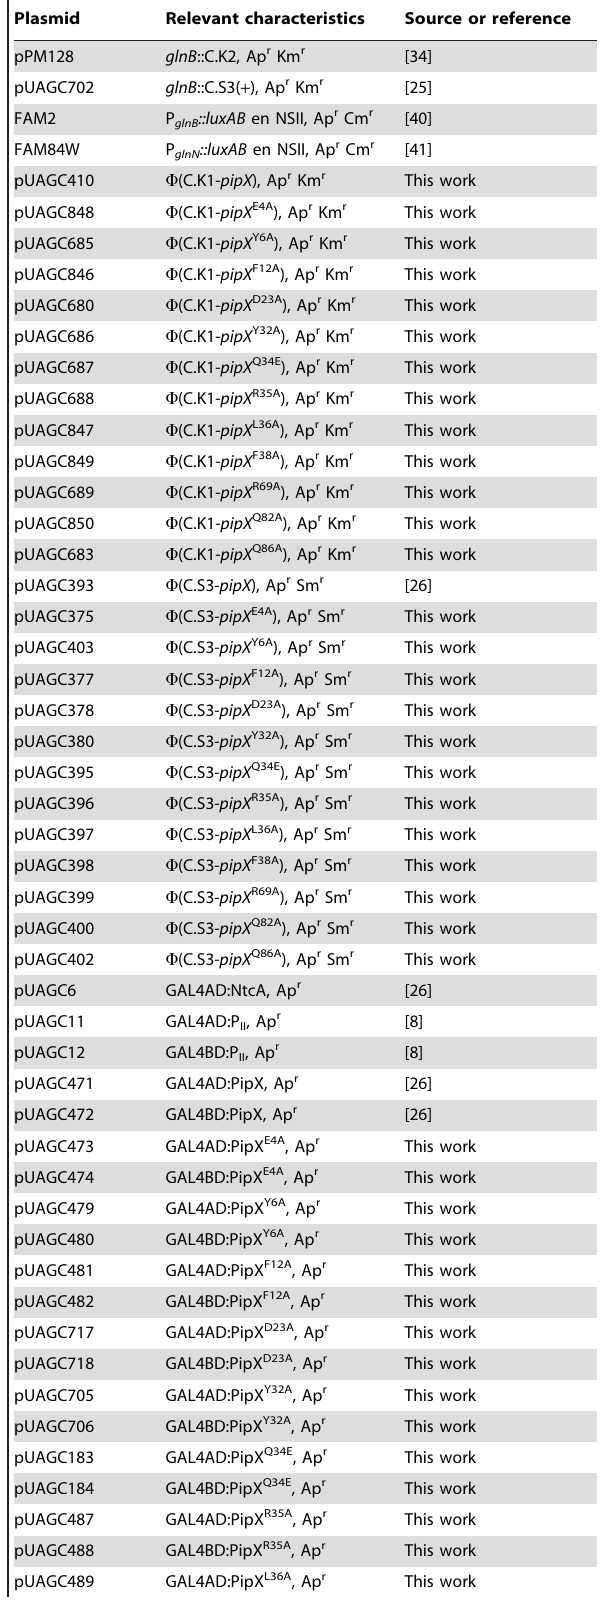
Table 2. Plasmids used in this study. Plasmid Relevant characteristics